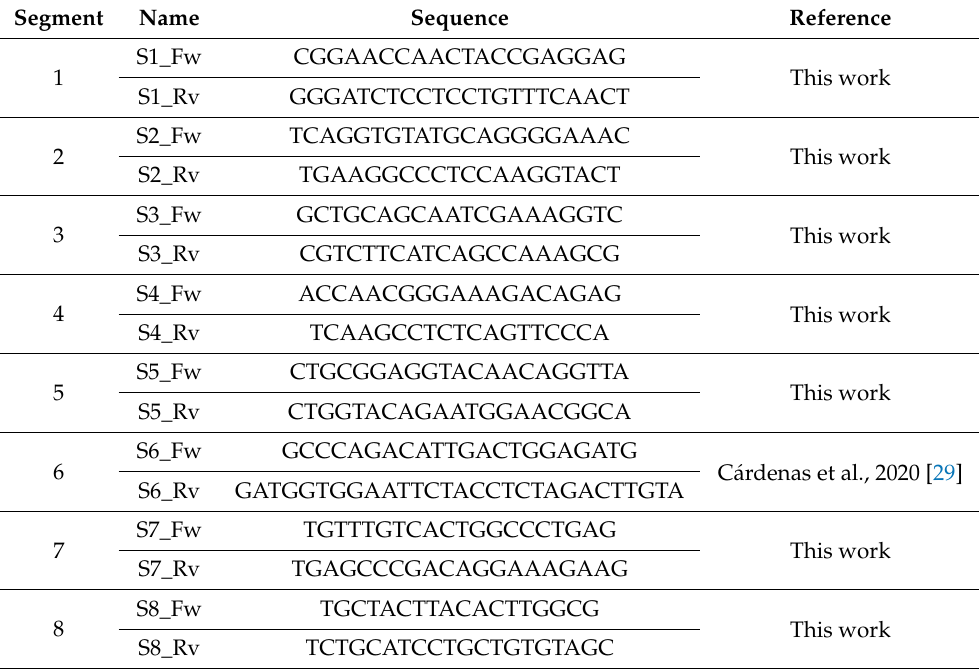
Table 2. Primers used for ISAV detection and Sanger